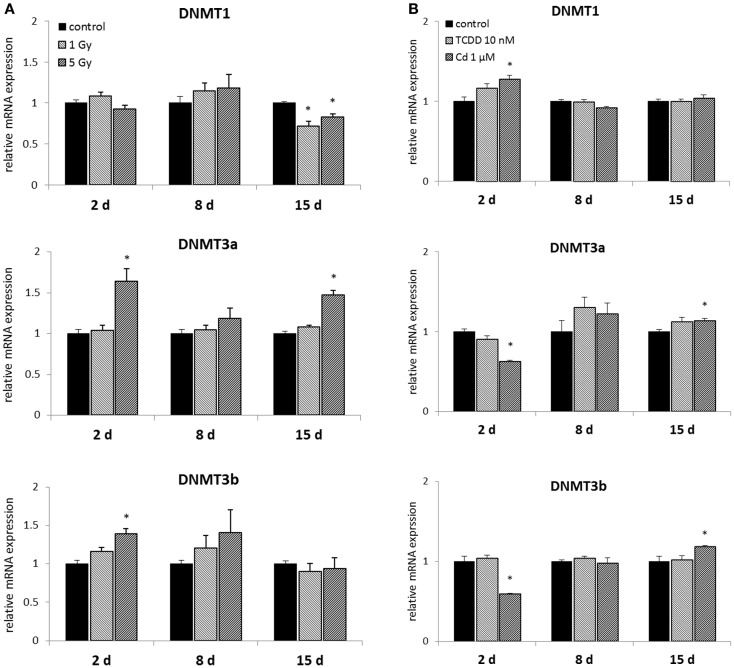
Direct (2 days) or delayed (8 and 15 days) mRNA expression of DNMT1, DNMT3a, and DNMT3b after (A) exposure to a single dose of 1 or 5 Gy ionizing radiation (n = 5 for 2 and 8 days, n = 3 for 15 days) or (B) 2 days of exposure to 10 nM TCDD or 1 μM cadmium (n = 3). An asterisk (*) represents a p-value <0.05.